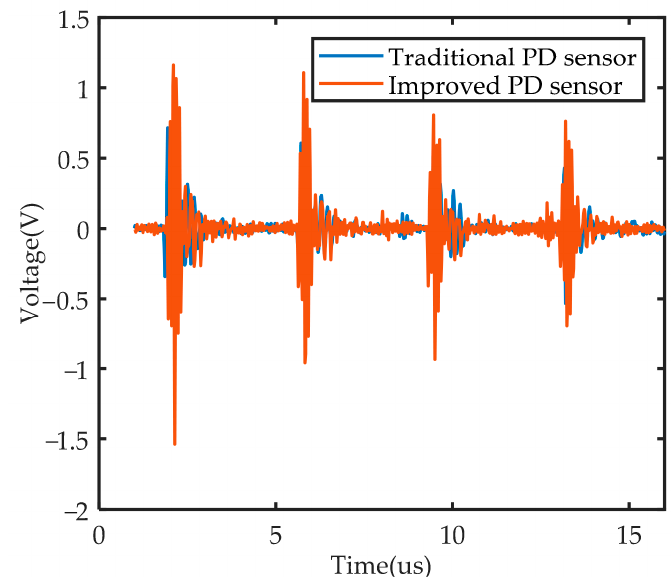
Figure 21. Experimental result of PD detection.